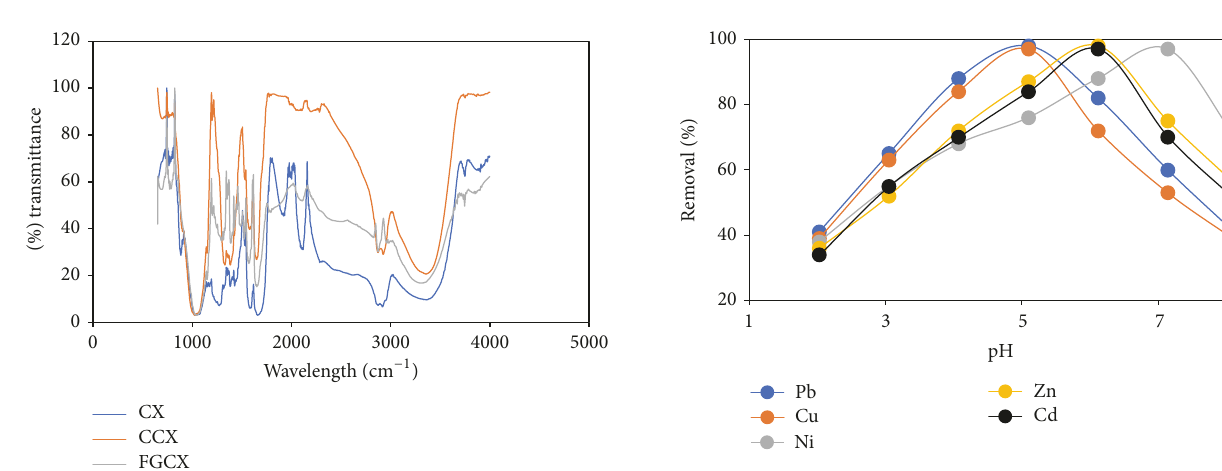
Figure 7: Effect of pH on percentage removal of heavy metal ions by FGCX (conditions: 7g/l FGCX; contact time: 70 min; Temperature: 25 ∘ C; initial concentration: 0.8mmol/L; agitation speed: 120 rpm).